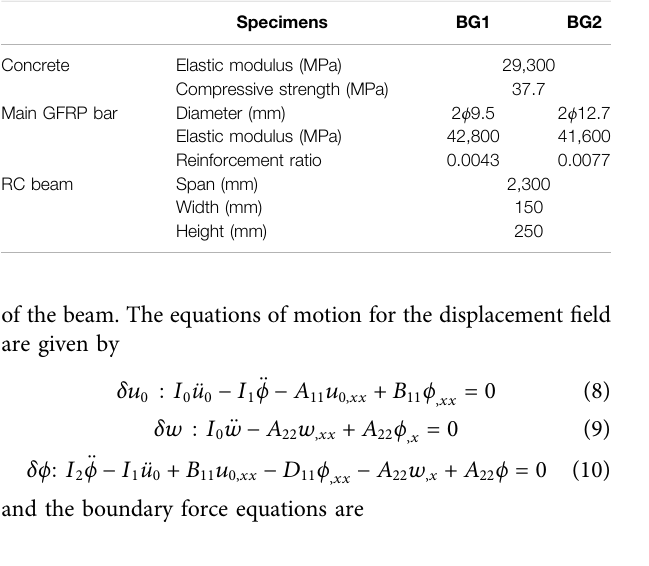
TABLE 1 | Material and geometrical properties of the tested